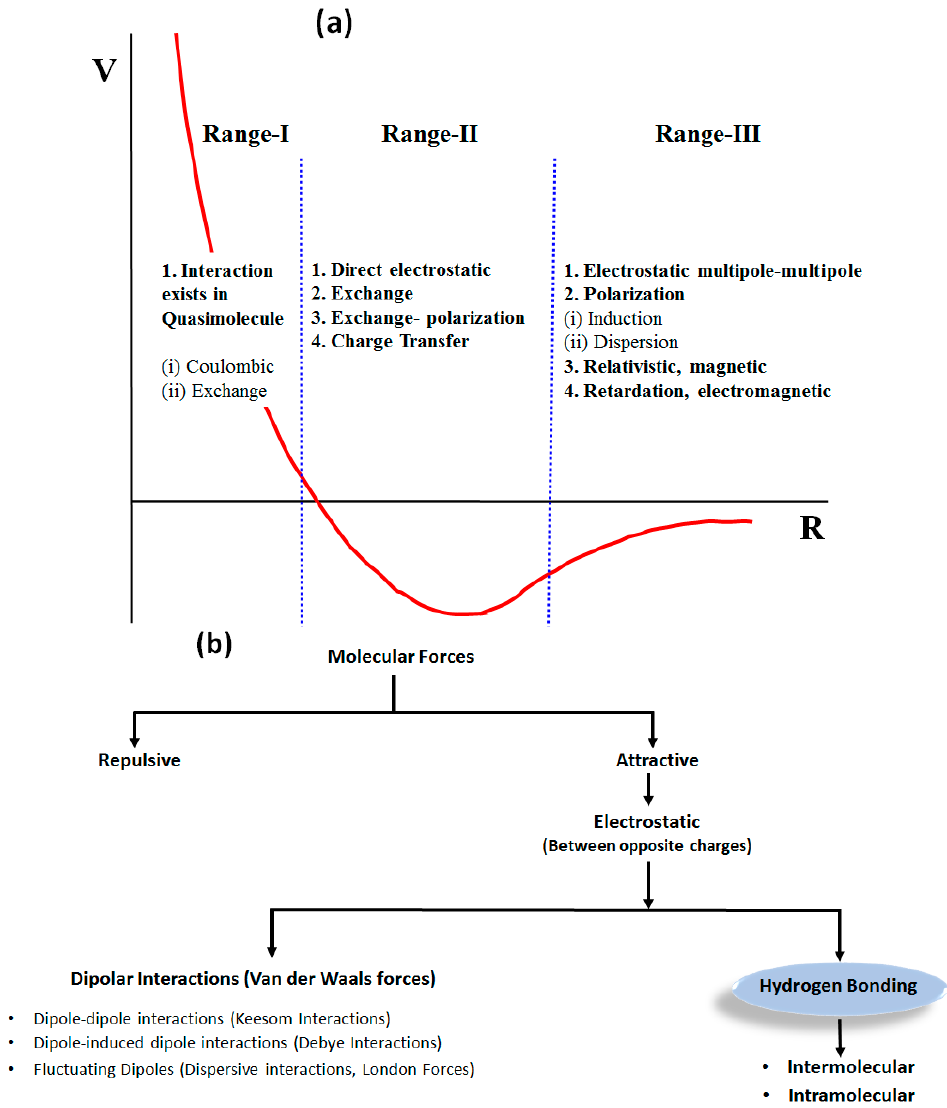
Figure 1. ( a ) The classification of intermolecular interactions on the basis of interatomic distances for a typical interatomic potential. Where R is the distance between the centers of masses of the molecules, V is the Lennard-Johns potential and the graph of V as the function of R is called Lennard-Johns model potential graph; ( b ) Schematic illustration of some of known molecular interactions. Some other molecular interactions that are not listed in the scheme may also be possible. This review is mainly focused on the intramolecular HB hence hydrogen bonding is highlighted in the scheme.